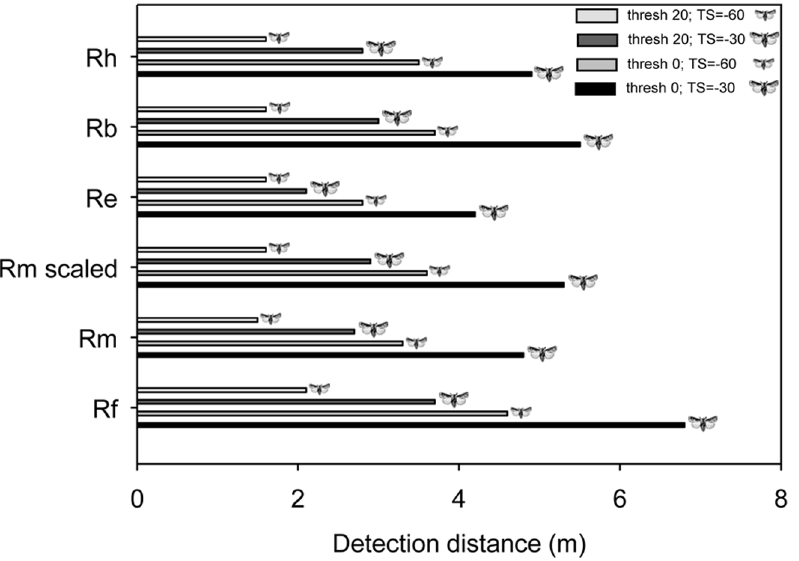
Figure 5. Estimated maximum prey detection distances for the five European species of horseshoe bat. The dark grey bars indicate maximum detection distances for large insects (target strength (TS)= 2 30 dB) for either an echo perception threshold (thresh) of 0 dB SPL or 20 dB SPL; the light grey bars show maximum detection distances for small insects (target strength (TS)= 2 60 dB) for either an echo perception threshold of 0 dB SPL or 20 dB SPL. Calculations were based on average maximum call intensities and an average peak echolocation call frequency as measured in this study. Species abbreviations as in the other figures. ‘Rm scaled’ indicated detection distances R. mehelyi would experience if the species called at the intensity we measured, but at a frequency as predicted by allometric scaling (97 kHz instead of 108